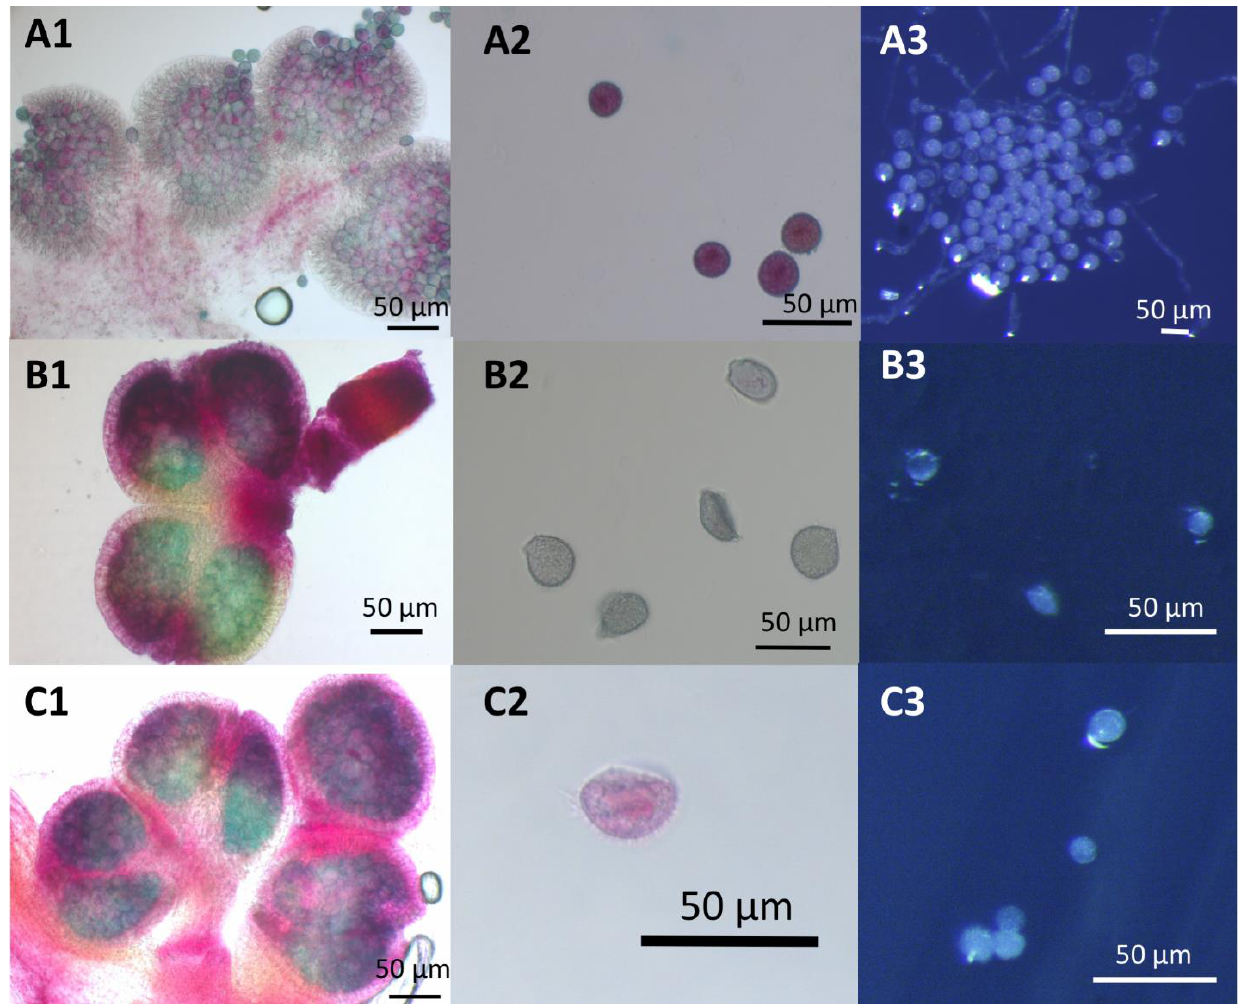
Figure 8. Pollen viability and germination assays for Lemna DWC114, DWC131, and DWC132 ( A ) L. gibba G3 DWC114 anthers and pollen ( B ) L. minor DWC131 anthers and pollen ( C ) L. minor DWC132 anthers and pollen (1 and 2) Anthers and pollen were stained with modified Alexander’s stain. (3) Pollen tube formation after 1 h of germination on E media.